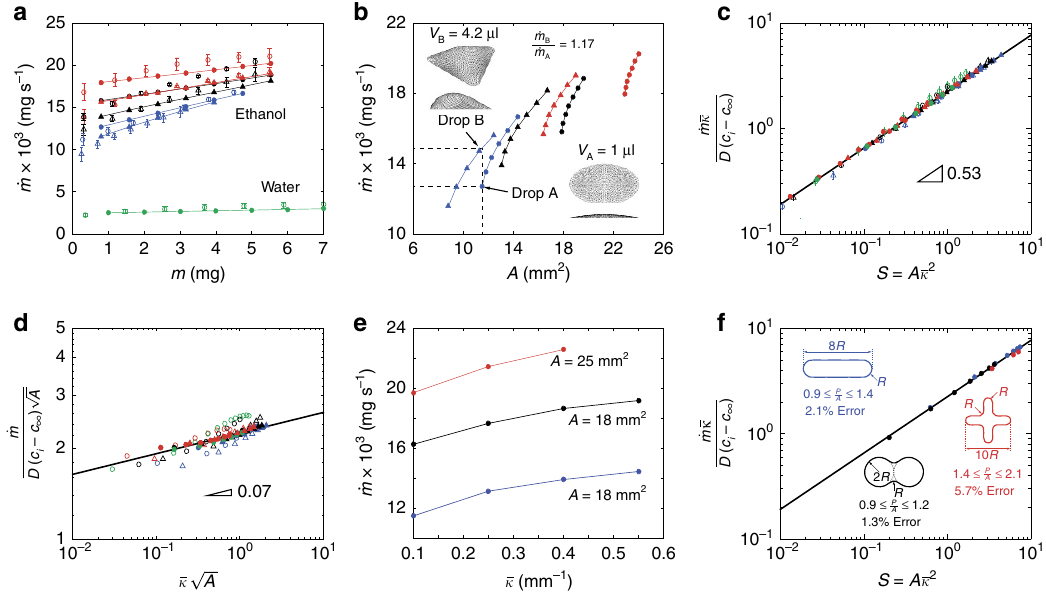
Figure 1 | Evaporation kinetics of non-heated sessile drops. ( a ) Experimental (hollow symbol) and numerical (filled symbol þ solid line) evaporation rates for sessile drops with circular (circular symbol) and triangular (triangle) contact areas of different perimeter lengths P and volume 1 r V r 7 m l. Blue corresponds to P ¼ 12mm, black and green to P ¼ 15mm and red to P ¼ 17mm. The error bars represent the s.d. of the experimental measurements. The room temperature and humidity were maintained constant at T a ¼ 23 (cid:2) C and RH ¼ 50%, respectively. The numerical evaporation rate is _ m ¼ R J (cid:5) n d A A where J ¼ (cid:3) D r c is the local evaporation flux, A the interfacial area, n the unit vector normal to the interface, D the molecular diffusivity and c the vapour concentration resulting from steady-state diffusion in the gas, that is, r 2 c ¼ 0, with appropriate boundary conditions. A detailed description of the model is available in the Methods section. ( b ) Numerical evaporation rates (extracted from a ) versus liquid–gas surface area A illustrating how two drops with the same P and A but different shape lead to significantly different evaporation rates. ( c ) Scaling law including the area-average interface mean curvature (cid:2) k that collapses all the data shown in a . ( d ) Re-plotting of the data and the scaling law to illustrate the effect of (cid:2) k . ( e ) Numerical evaporation rates for different spherical drops with the same A but varying (cid:2) k in the range of the characteristic values examined experimentally. ( f ) Numerical simulations testing the scaling law performance in more ‘exotic’ shapes with P ¼ 15mm and varying V prescribed canonical contact-line geometries with P ¼ 15 mm,